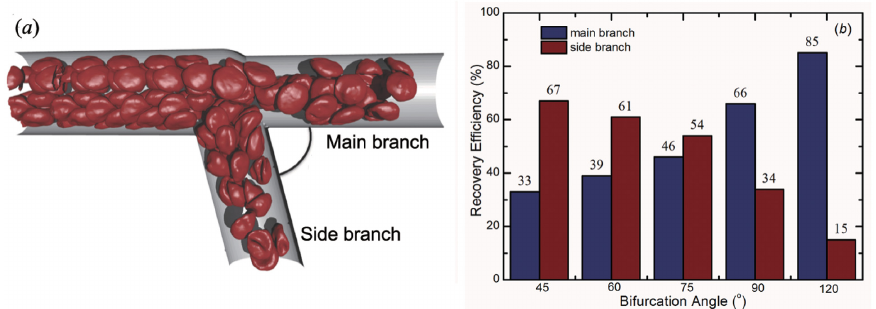
Fig 6. Effect of bifurcation angle on particle recovery efficiency. ( a ) A sketch of the microvascular bifurcation model by changing the bifurcation angle θ . In this model, the diameter of the parent branch is 20.0 μ m , and the diameters of two daughter branches are both 16.5 μ m . The average velocity of blood flow in parent branch is about 0.12 mm / s . ( b ) Relationship between the particle recovery efficiency and bifurcation